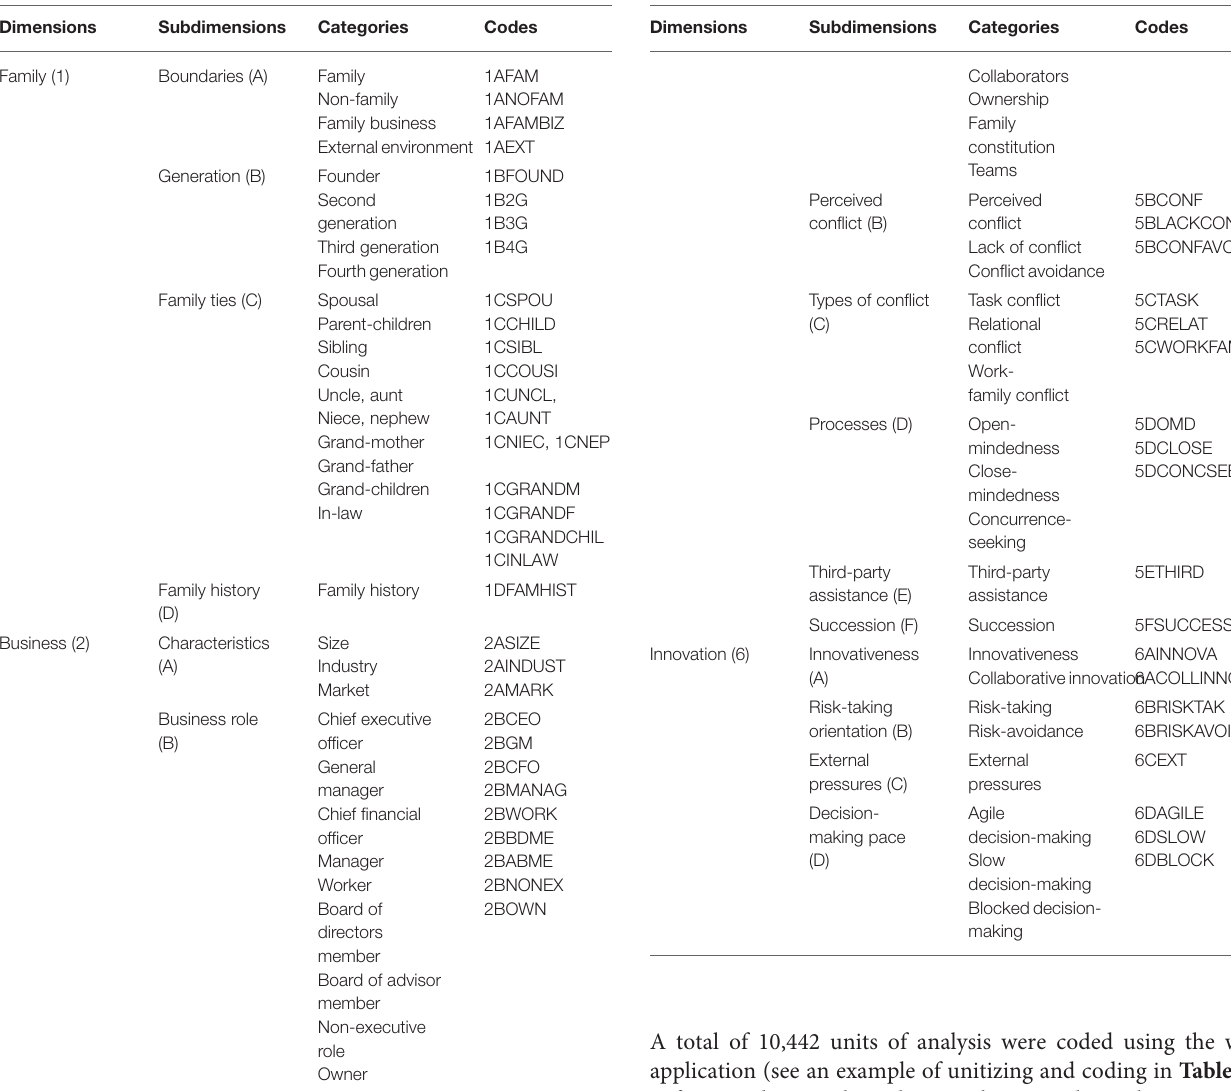
TABLE 3 | A summary of indirect observation